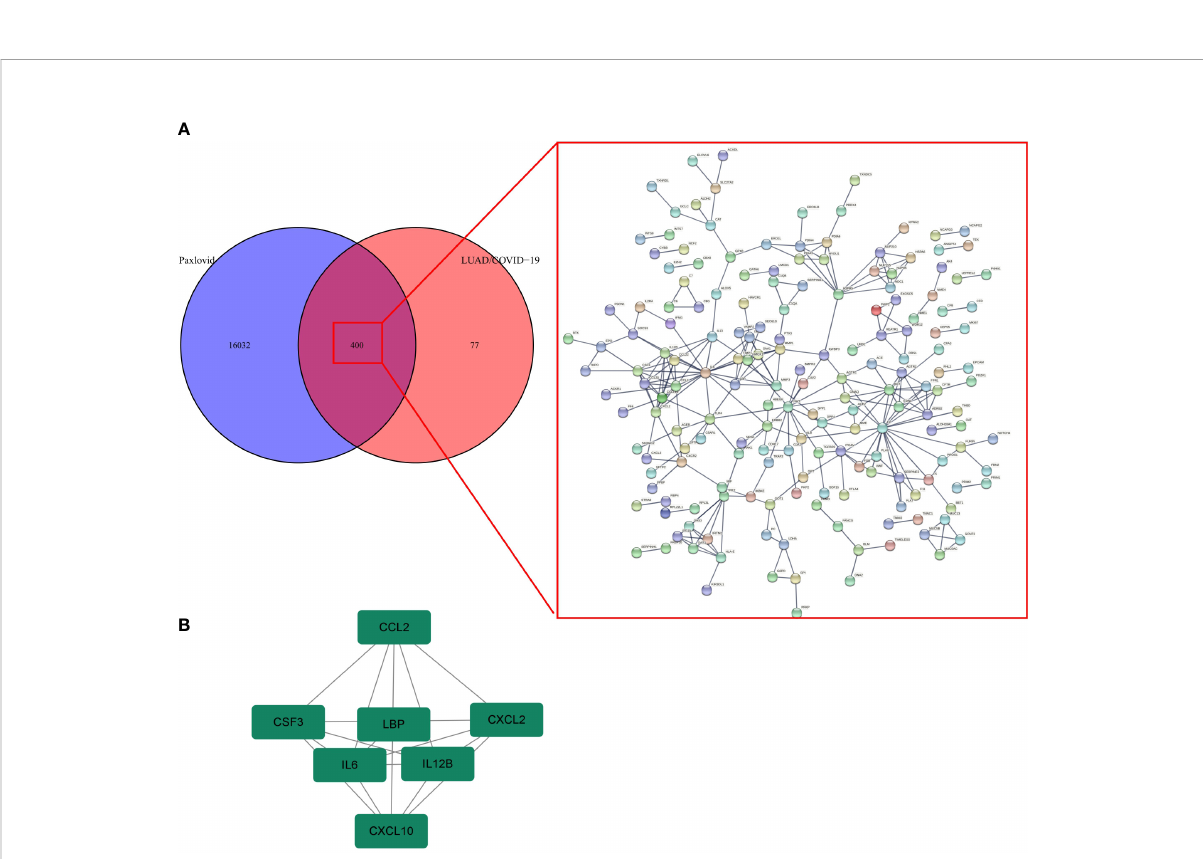
FIGURE 7 Gene network analysis of Paxlovid against LUAD/COVID-19. (A) STRING analysis indicating protein-protein interaction networking mediated by 400 intersecting targets of niacin against LUAD/COVID-1 9. (B) Cytoscape analysis representing the protein interaction network related to the action of Paxlovid against LUAD/COVID-19. Seven core targets-CXCL2, CCL2, IL12B, CSF3, LBP, IL6 and CXCL10-are